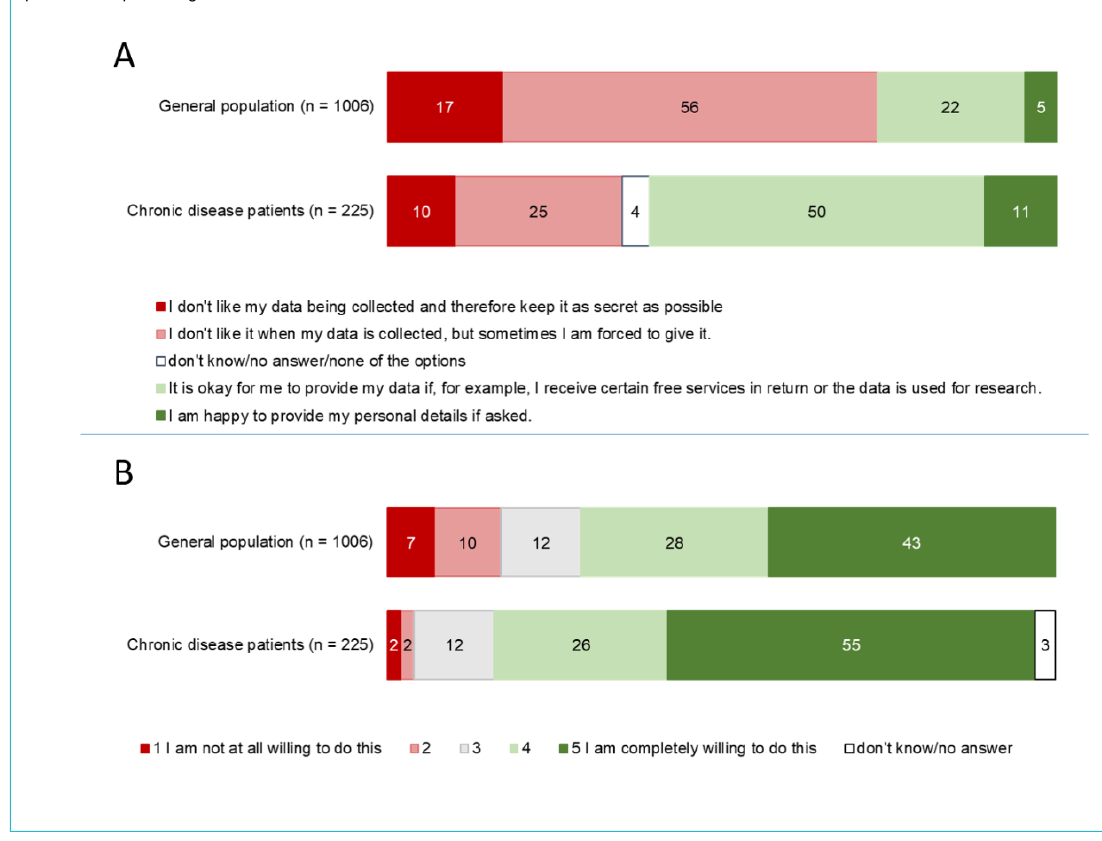
Figure 2: Willingness to share data. A General personal data. B Anonymised health data for medical research. The different categories are presented in